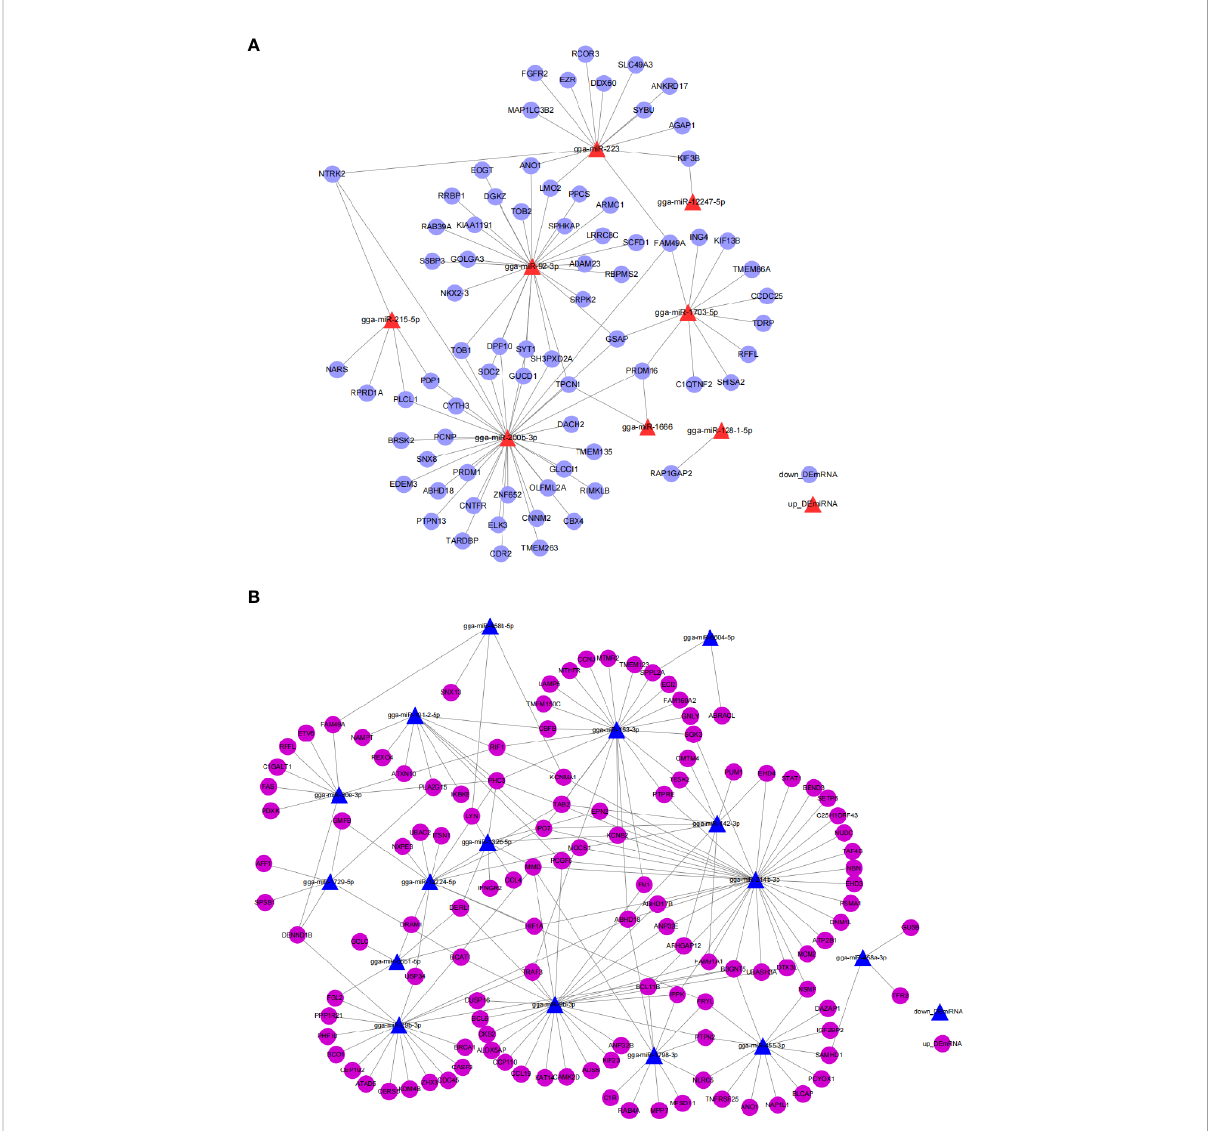
FIGURE 3 Networks of DEmiRNA - DEmRNA involved in the immune response to E. tenella infection predicted by miRDB. (A) Networks of up _ DEmiRNA - down _ DEmRNA generated using Cytoscape 3.7.2. (B) Networks of down _ DEmiRNA - up _ DEmRNA generated using Cytoscape